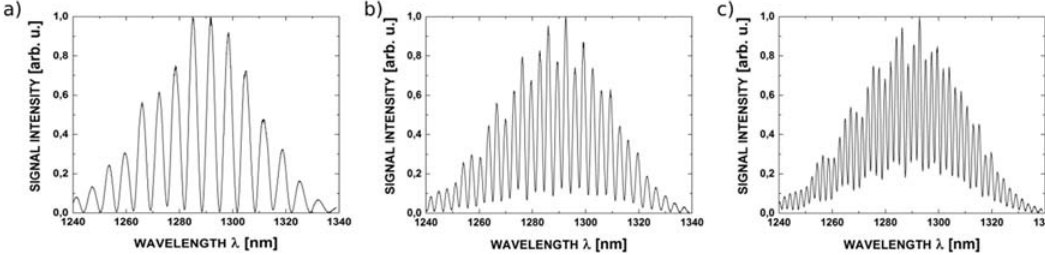
Figure 7. The measurement signal with the central wavelength 1300 nm for ZnO layer thickness of 200 nm and the length of Fabry-Pérot cavity: ( a ) 100 µm; ( b ) 200 µm and ( c ) 300 µm.